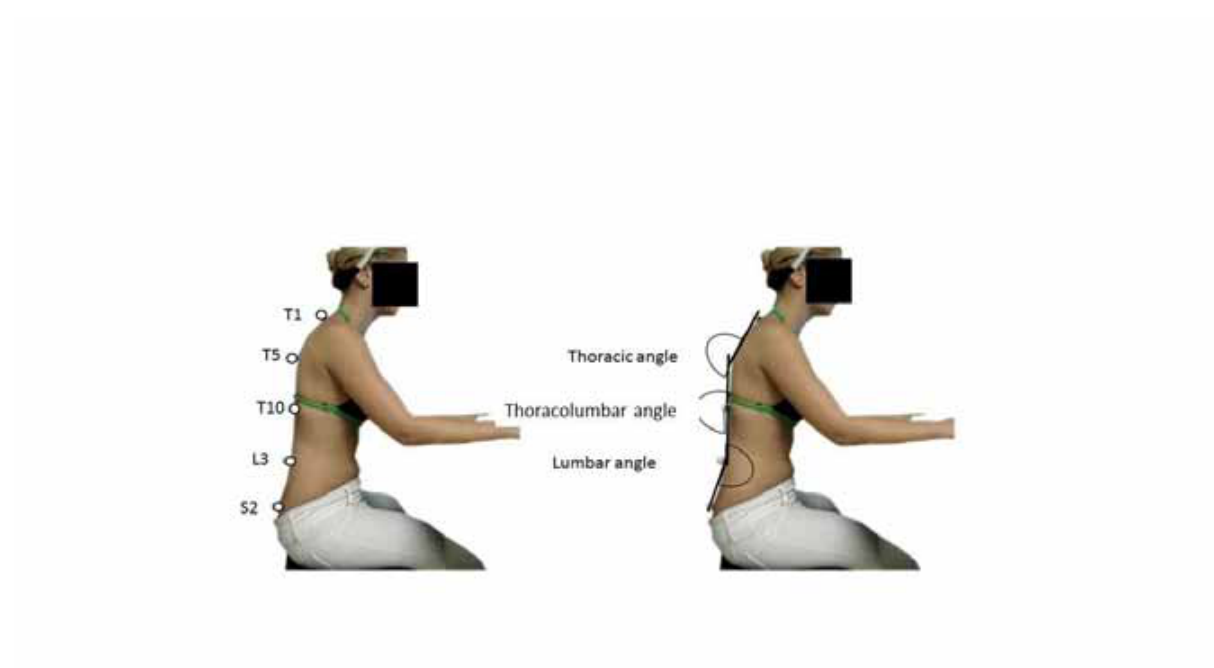
Figure 2 – Illustrative image showing the kinematic markers used to measure lumbar, thoraco-lumbar and thoracic angles (adapted from Claus et al., 2009).